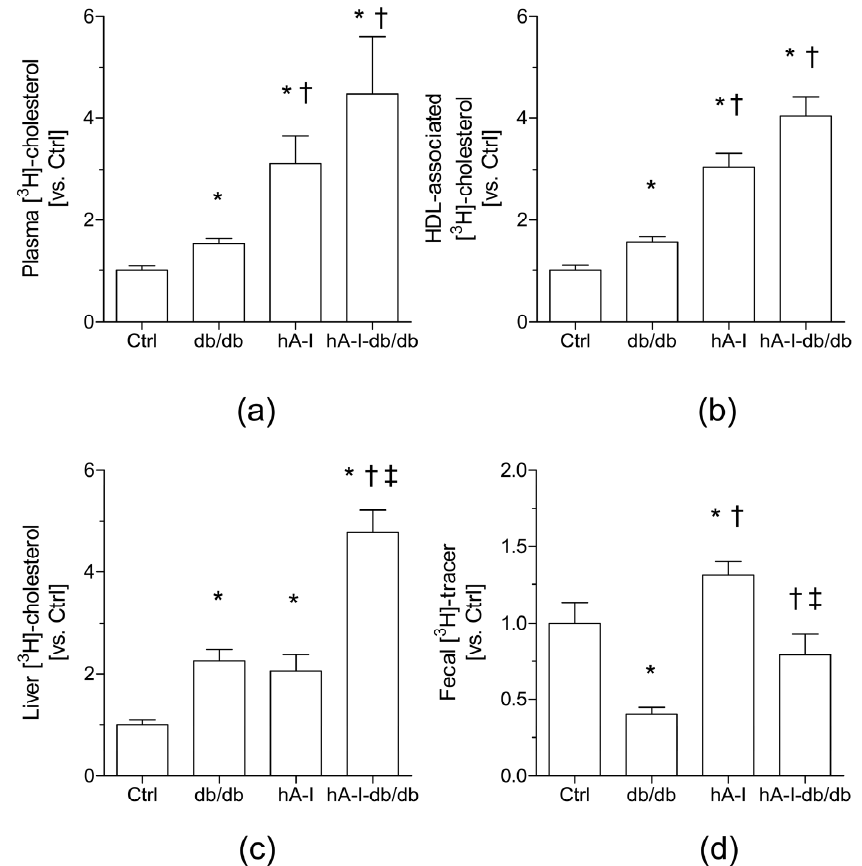
(Table 1), significantly higher relative levels of [ 3 H]-cholesterol ( ∼ 2-fold) were detected in the hApoA-I-containing HDL than in HDL from db/db mice (Figure 2b). Furthermore, the relative increase in HDL-associated [ 3 H]-cholesterol levels in hA-I-db/db mice was roughly for the same as the sum of the levels in db/db ( ∼ 1.5-fold, p < 0.05) and hA-I mice ( ∼ 3-fold, p < 0.05) (Figure 2b).